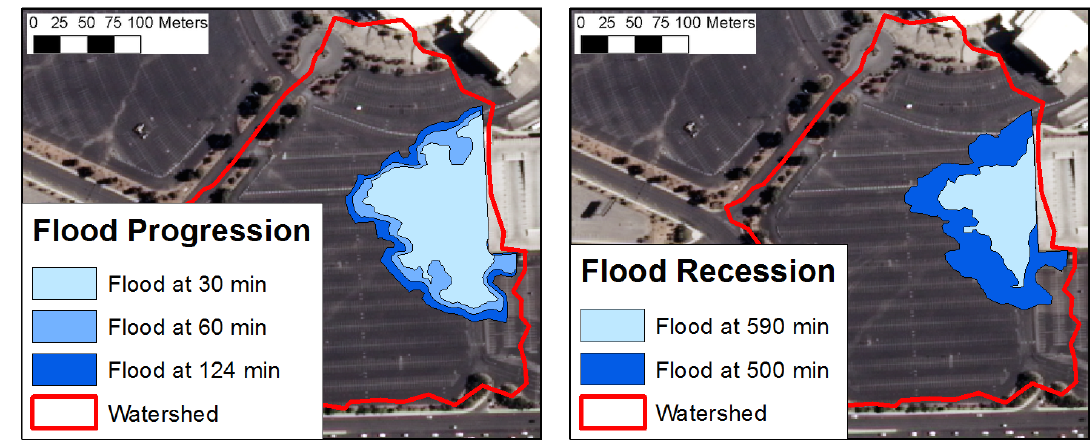
Figure 12. Spatiotemporal map of inundation at